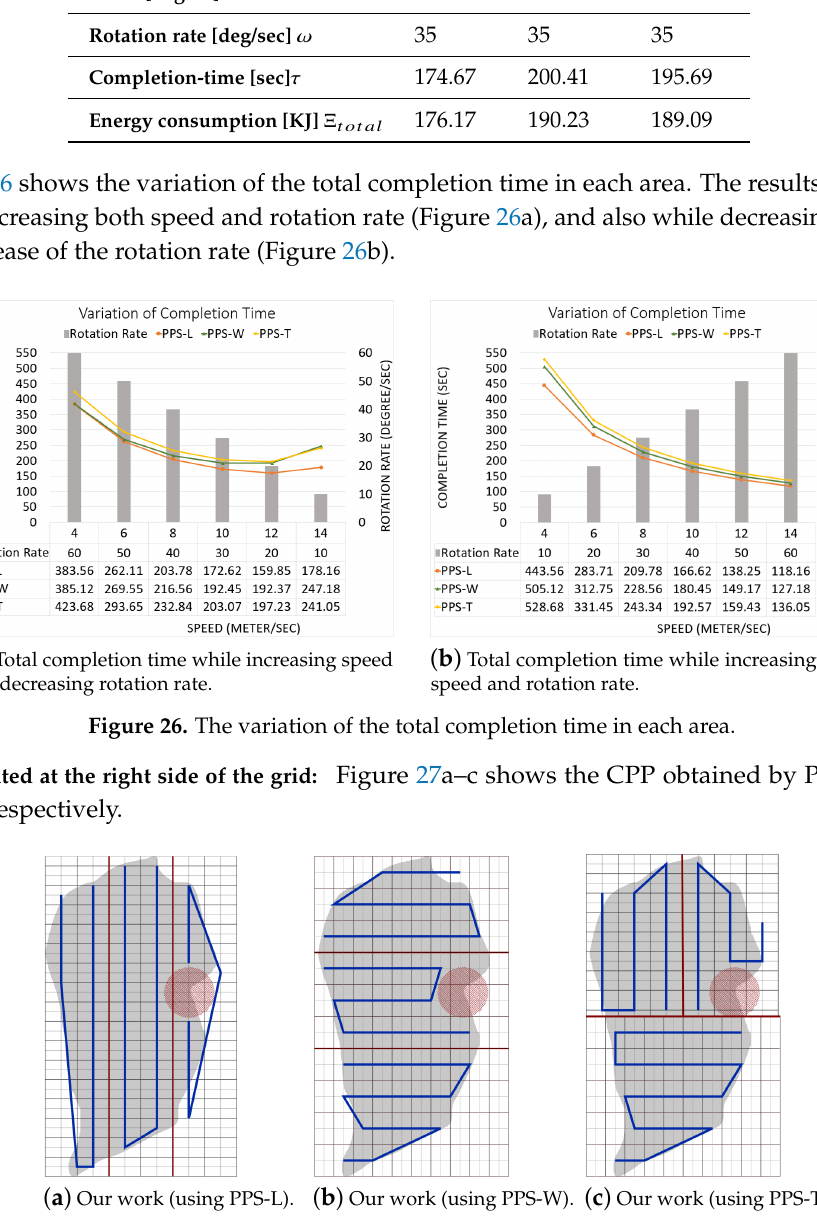
Figure 27. The paths generated by the algorithm by our algorithm using PPS-L, PPS-W and PPS-T with NFZ located at the right side of the